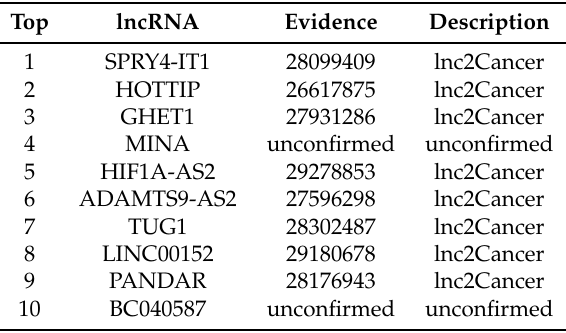
Table 3. The top ten lncRNA candidates for colon cancer.